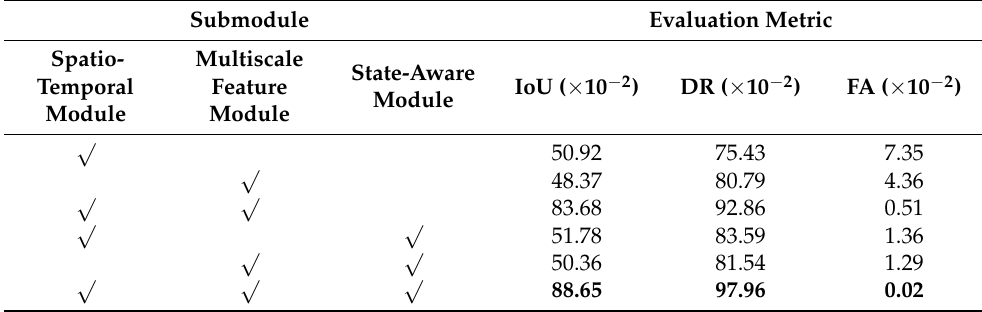
Table 6. Ablation studies on components of our method. The public dataset is taken as a